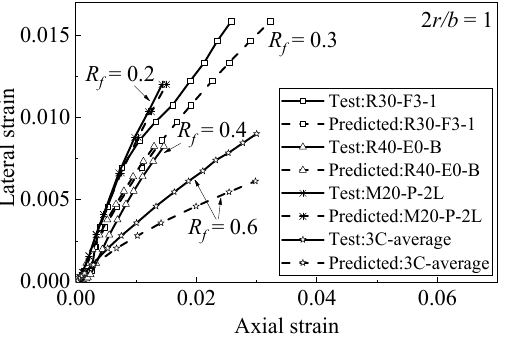
Figure 4. Performance of Chan et al.’s [10] axial–lateral strain model. (R30-F3-1 [11], R40-E0-B [17], M20-P-2L [19], 3C-average [21])